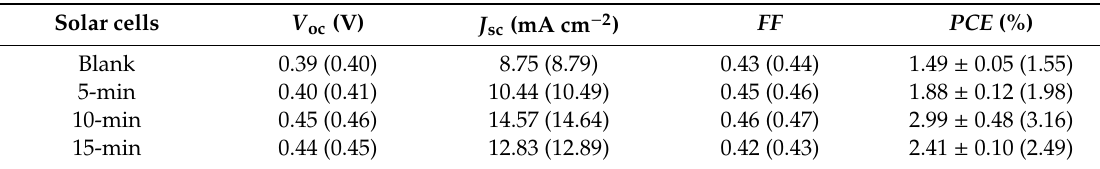
Figure 5. The J - V curves of QDSSCs based on TiO 2 -passivated ZnO HMS by immersing in TiCl 4 aqueous solution for 0 min (blank), 5 min (5-min), 10 min (10-min), and 15 min (15-min), respectively. Table 1. Average photovoltaic performance and standard deviation extracted from J - V curves of QDSSCs based on ZnO HMS passivated with TiO 2 by immersing in TiCl 4 aqueous solution for 0 min